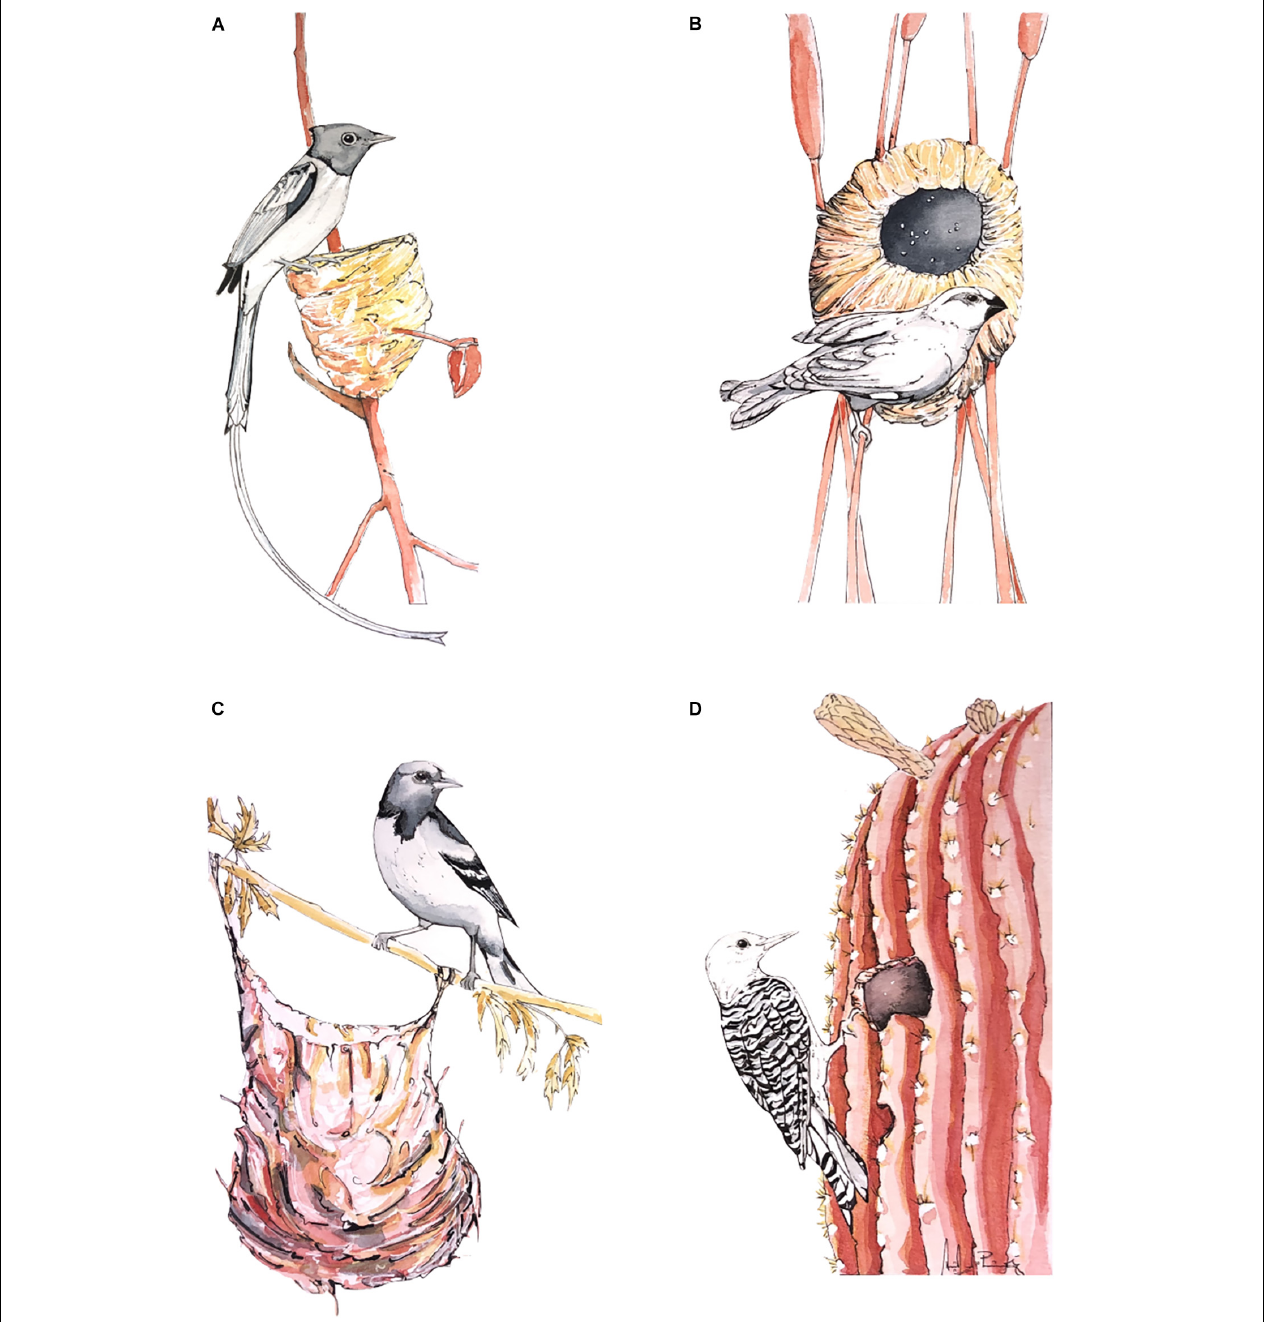
FIGURE 1 | Bird nest shape classification (A) supported cup from Terpsiphone mutata ; (B) dome from Amblyospiza albifrons ; (C) suspended cup (pouch) from Icterus galbula ; (D) cavity from Melanerpes uropygialis . Colors were chosen to contrast birds from nests and do not depict natural colors. Illustration by